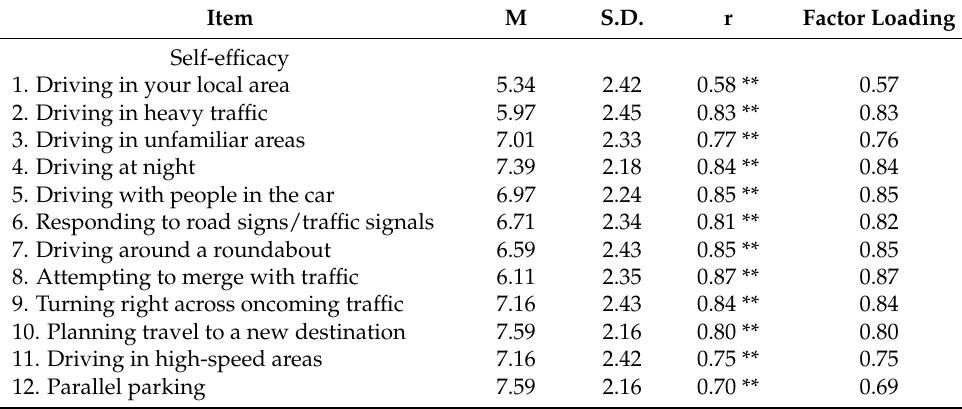
Table 7. ADSES factor structure and factor loading.